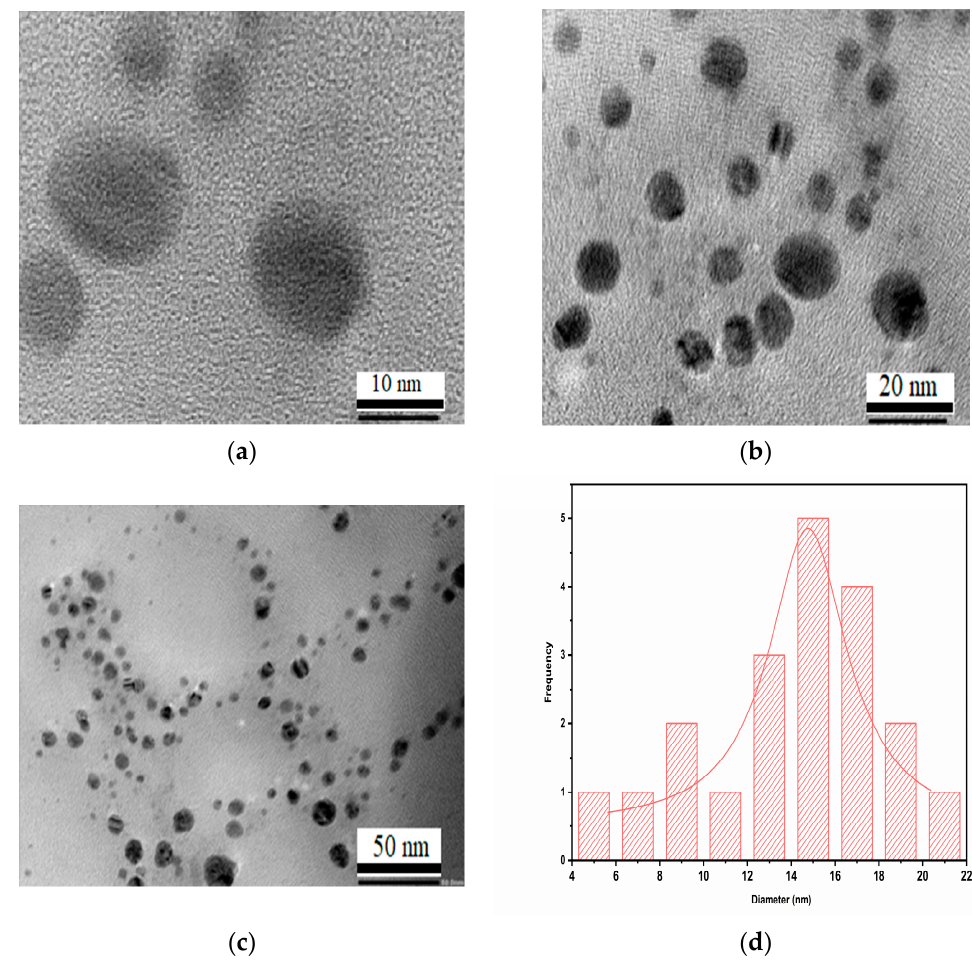
Figure 5. HR ‐ TEM micrographs showing the presence of AgNPs recorded at ( a ) 10 nm, ( b ) 20 nm, and ( c ) 50 nm magnification levels; ( d ) histogram showing distributions of the size of AgNPs. By using FTIR analysis, the various functional groups in the leaf extract and on the surface of their biosynthesized AgNPs were located. These functional groups were primarily responsible for reducing Ag + to Ag and stabilizing the biosynthesized AgNPs. The analysis of the FTIR spectra of the aqueous leaf extract revealed the presence of various characteristic peaks at 3325.91, 2950.23, 2838.78, 1646.76, 1409.43, 1113.70, and 1014.15 cm − 1 , and their biosynthesized AgNPs also showed peaks at 3339.35, 2926.19, 2834.63, 1642.85, 1403.15, and 1015.91 cm − 1 , respectively (Figure 6).